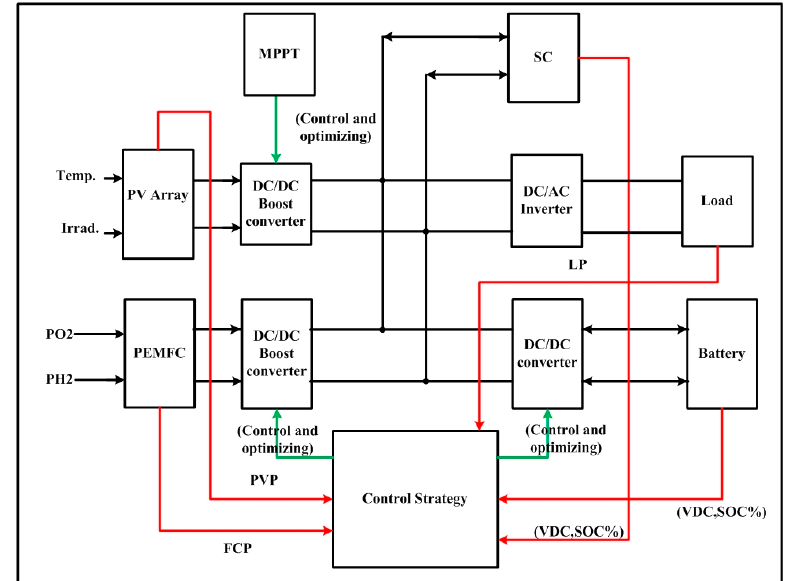
Figure 2. Block diagram of the proposed system.